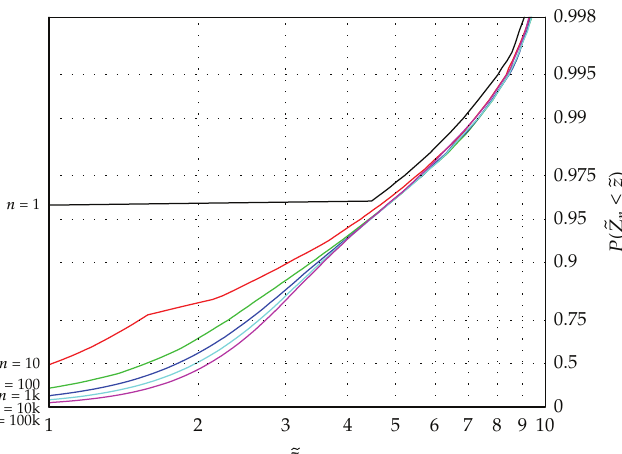
(cid:20) Z ∗ is computed with 10 6 Monte Carlo simulations. The interval n (cid:5) (cid:6) takes value of (cid:5) 0 . 80 , 0 . 95 (cid:6) . The curves from the top 0 ,λ 0